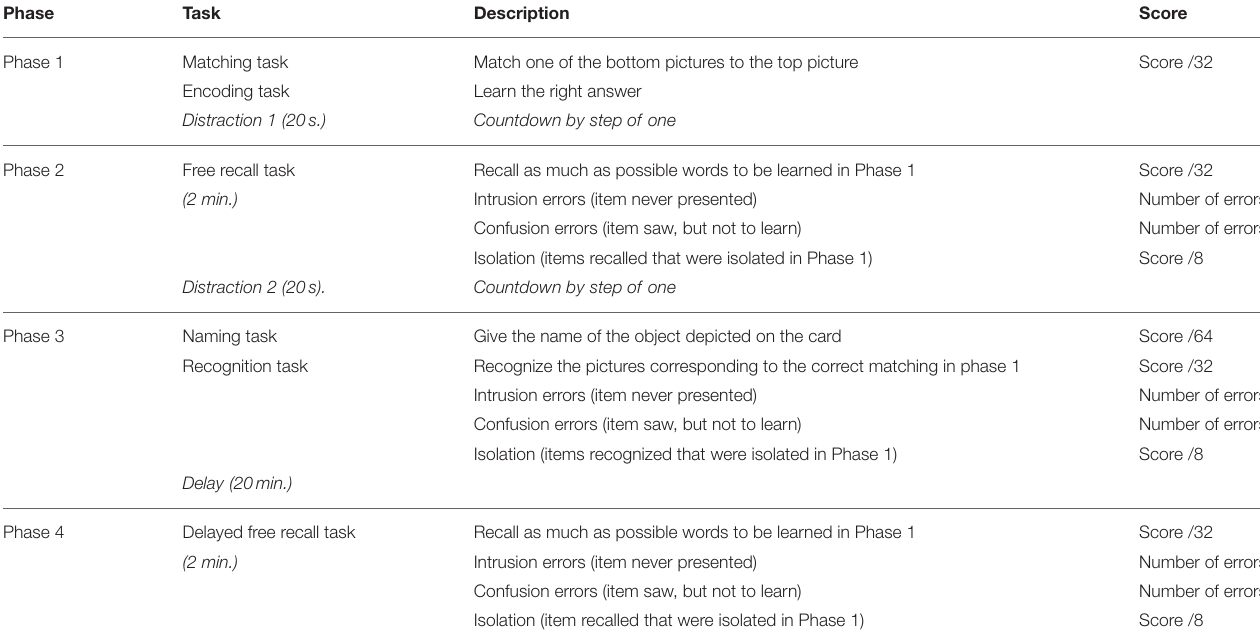
TABLE 4 | Summary of the procedure used in the SEMEP with the different scores